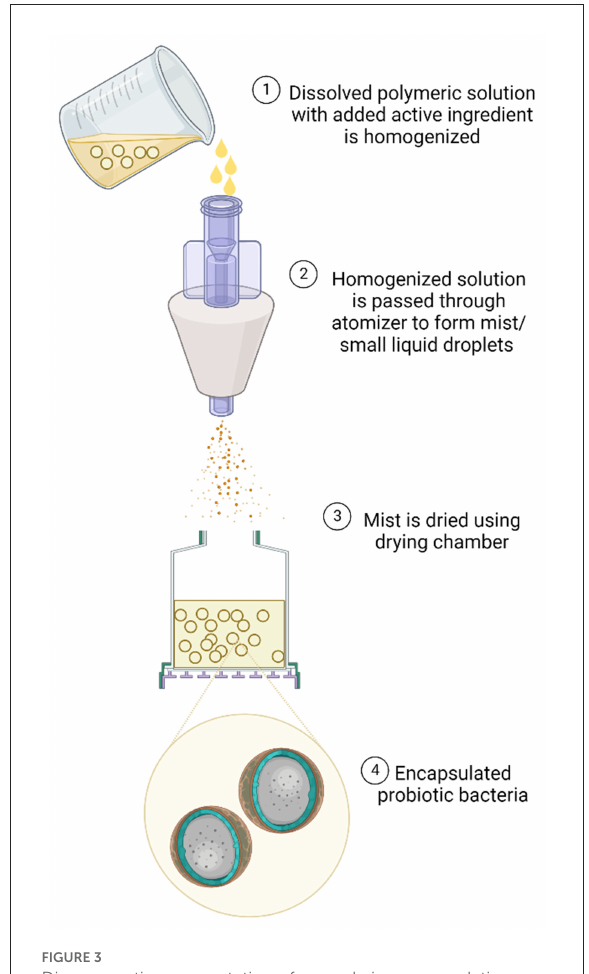
FIGURE3 Diagrammatic representation of spray drying encapsulation